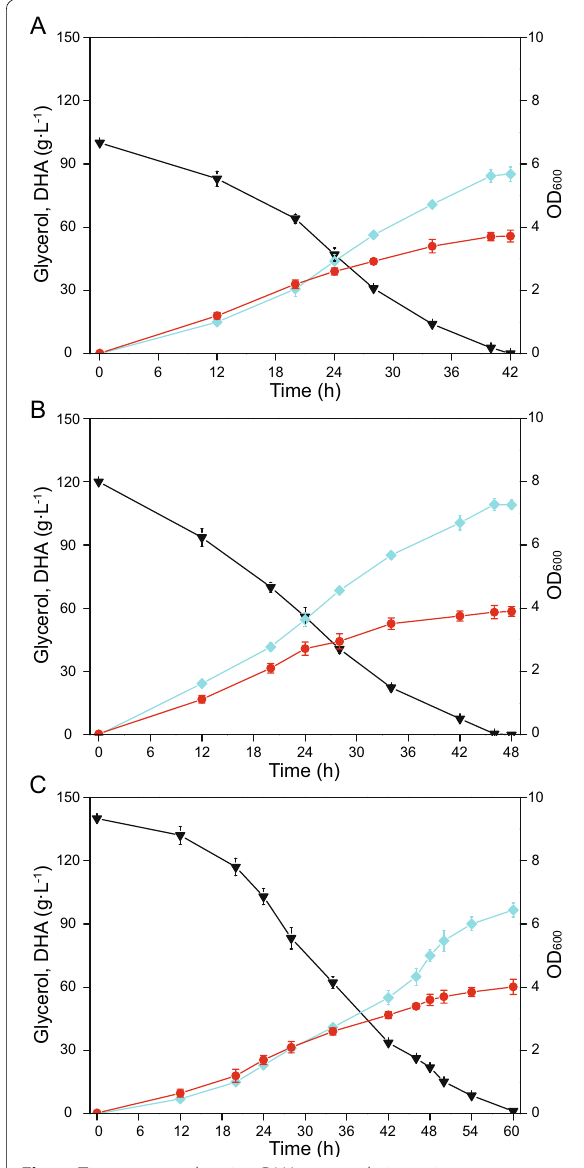
6 t i m e s i n t e r m i tt en t f eed i ng